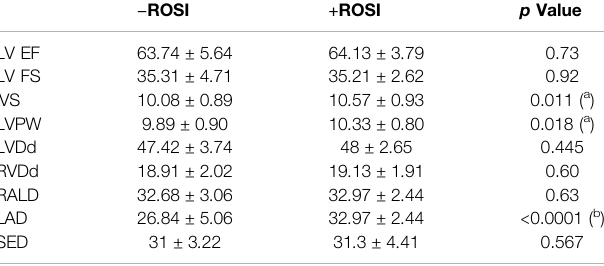
TABLE 3 | Physical and biochemical characteristics of the study patients. TABLE 4 | Echocardiographic parameters of the study -ROSI